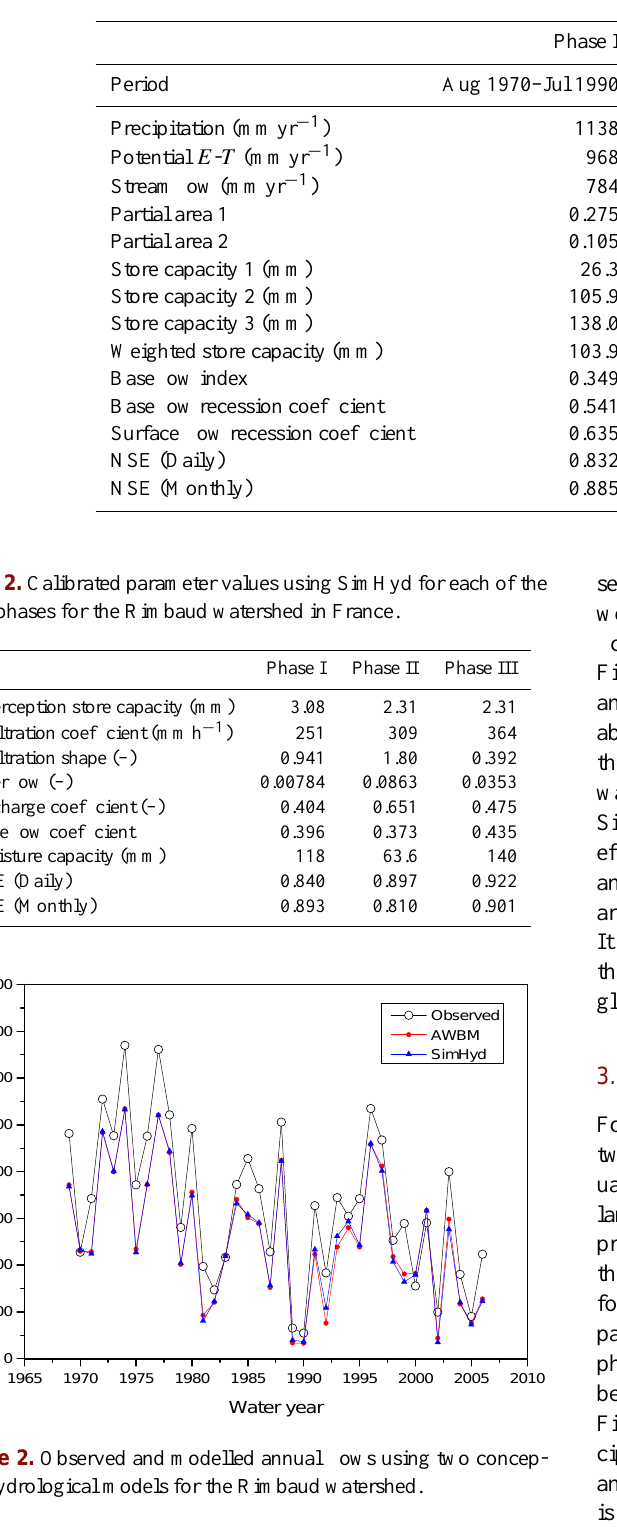
Table 1. Precipitation, potential evapotranspiration, stream flow, and calibrated parameter values using AWBM for each of the three phases for the Rimbaud watershed in France.